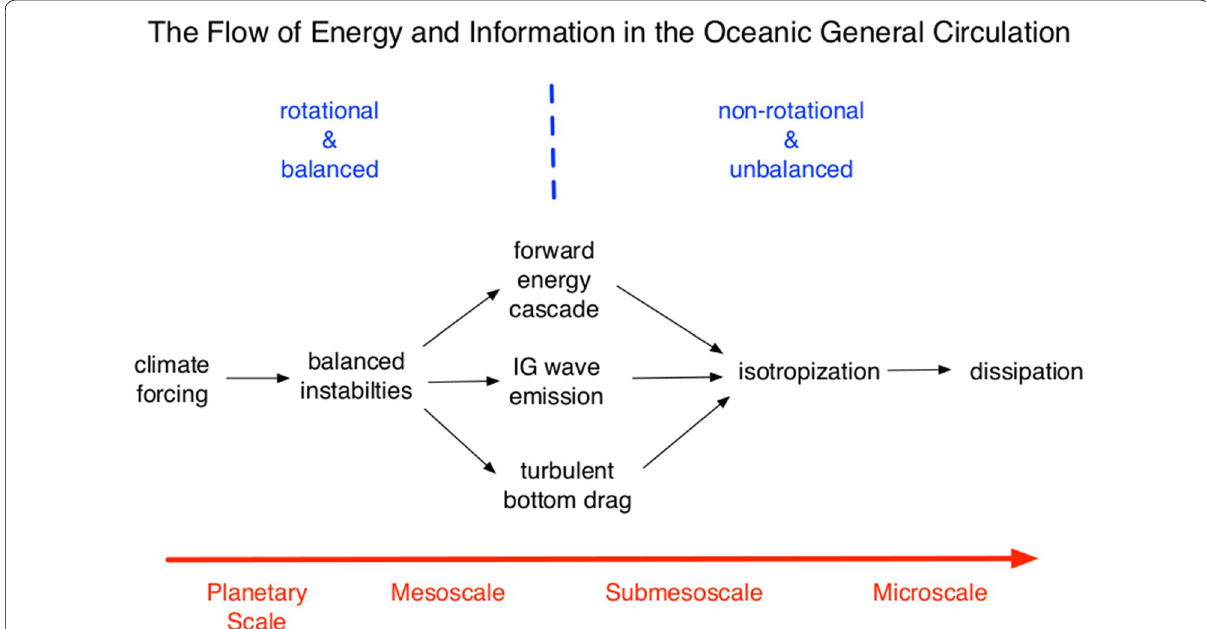
Fig. 1 Stages in the oceanic general circulation from planetary scale forcing to microscale dissipation and mixing: climate forcing by wind stress and air-sea buoyancy flux; balanced flow dynamics (e.g., mostly geostrophic and hydrostatic); submesoscale transitional dynamics; and microscale flows with only a weak influence from Earth’s rotation, a mostly unbalanced momentum dynamics with large accelerations, and an approximate equivalence of vertical and horizontal lengths scales, h ∼ ℓ . The Rossby and Froude numbers, Ro and Fr , start from very low values at the planetary scale, pass through O ( 1 ) values within the submesoscale regime, and end up with large values at the